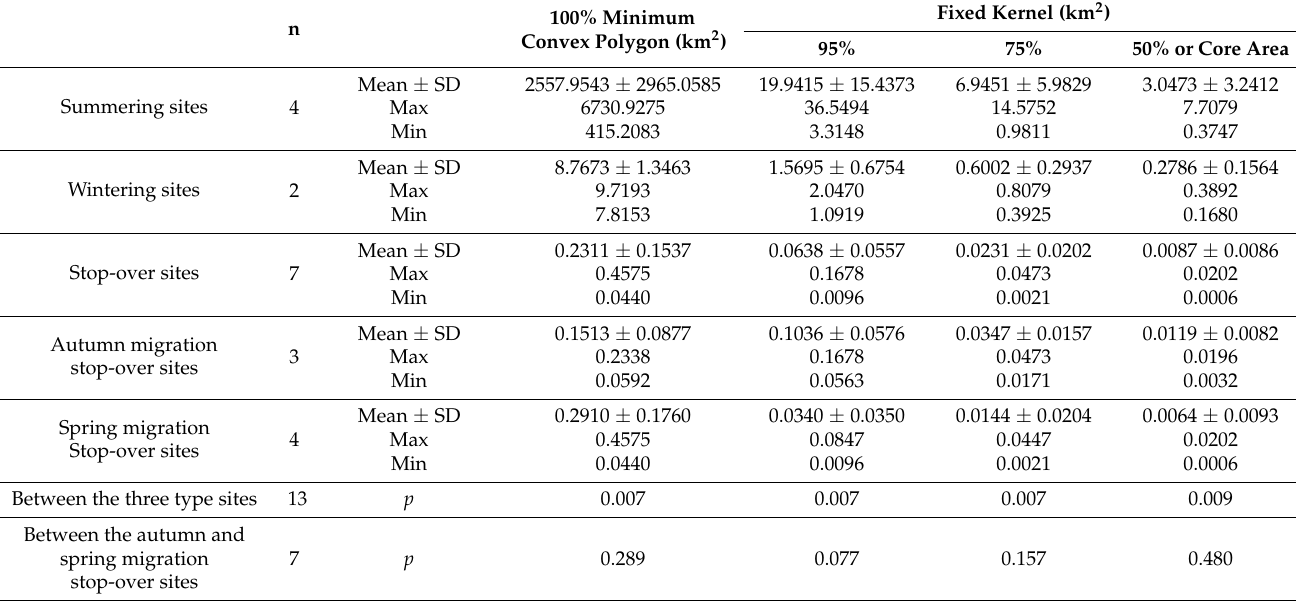
Table 4. Statistical value based on Mann–Whitney U and Chi-square tests of home range of two Chinese